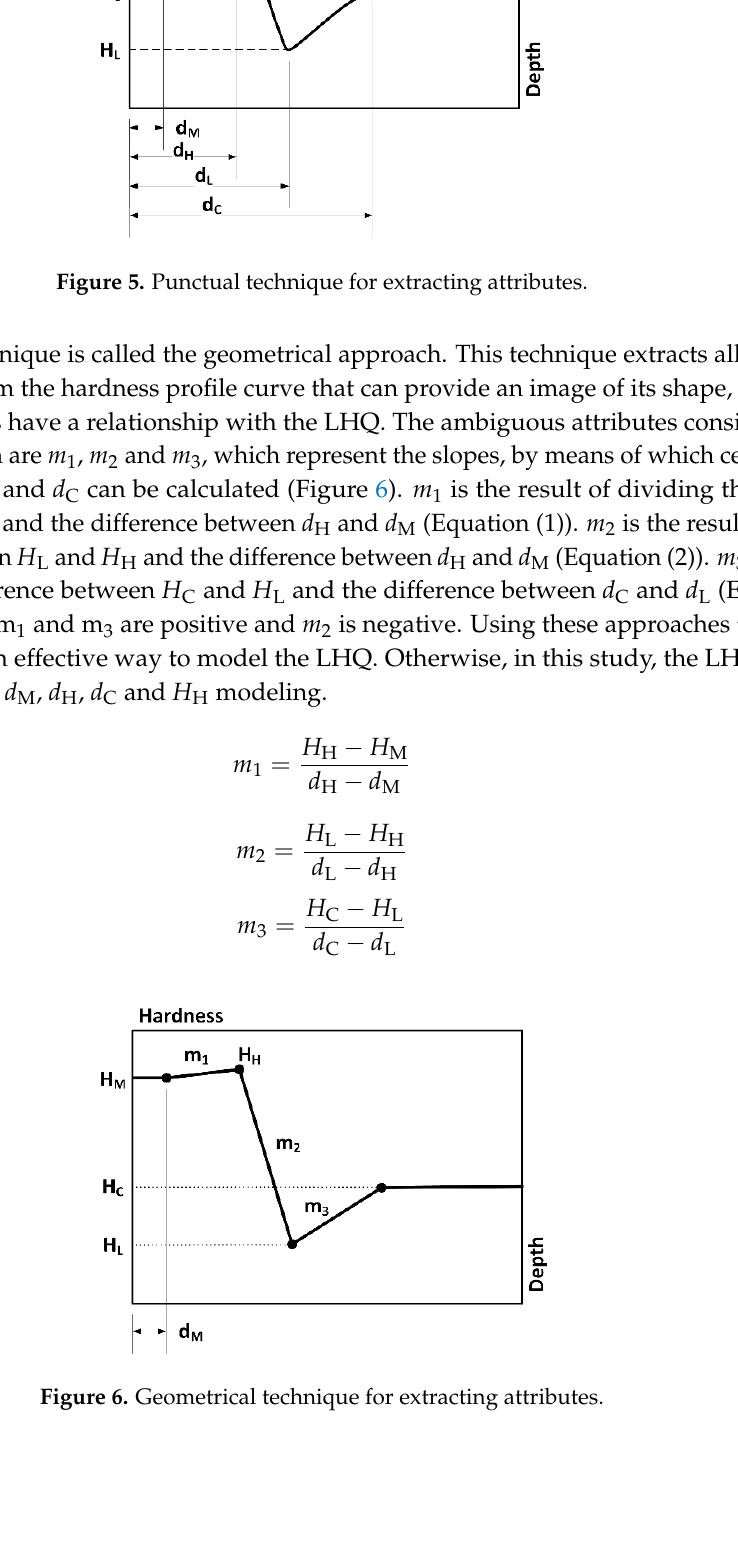
Figure 7. Punctual ANN model architecture.